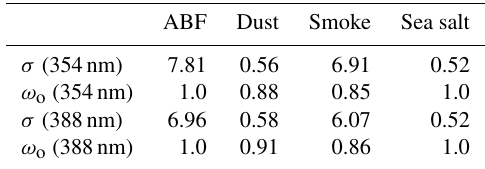
Table 1. Mass extinction efficiencies ( σ , m 2 g − 1 ) and single- scattering albedos ( ω o ) used in this study. ABF Dust Smoke Sea salt σ (354nm) 7.81 0.56 6.91 0.52 ω o (354nm) 1.0 0.88 0.85 1.0 σ (388nm) 6.96 0.58 6.07 0.52 ω o (388nm) 1.0 0.91 0.86